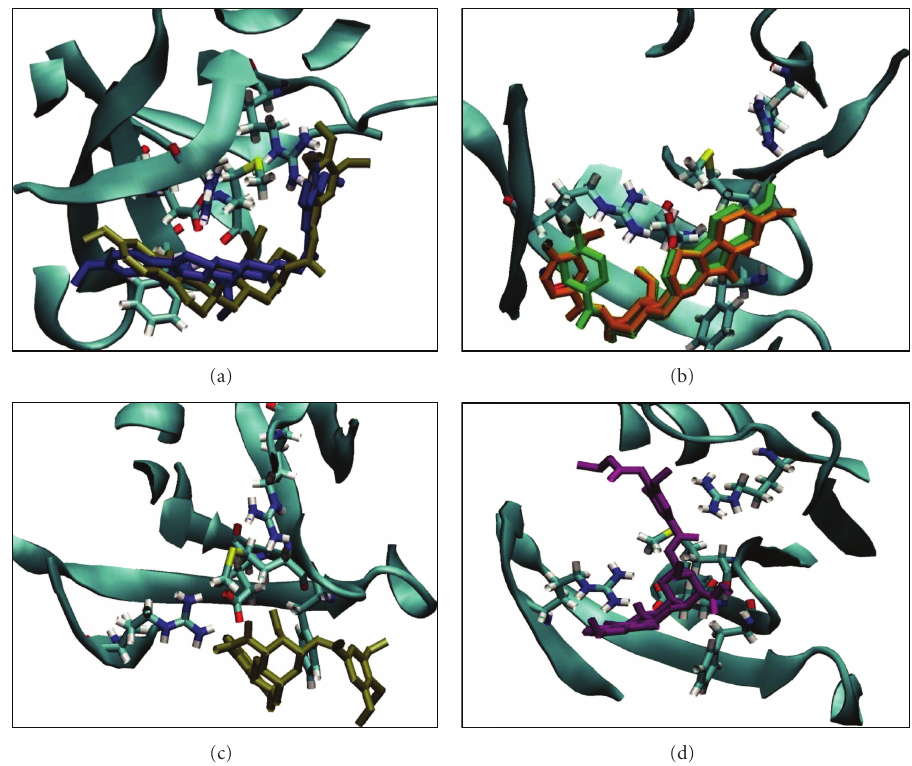
Figure 5: Predicted modes of binding of reserpine and rescinnamine derivatives include: (a) reserpine-like; (b) flipped; (c) mismatch-like; (d) nonspecific or